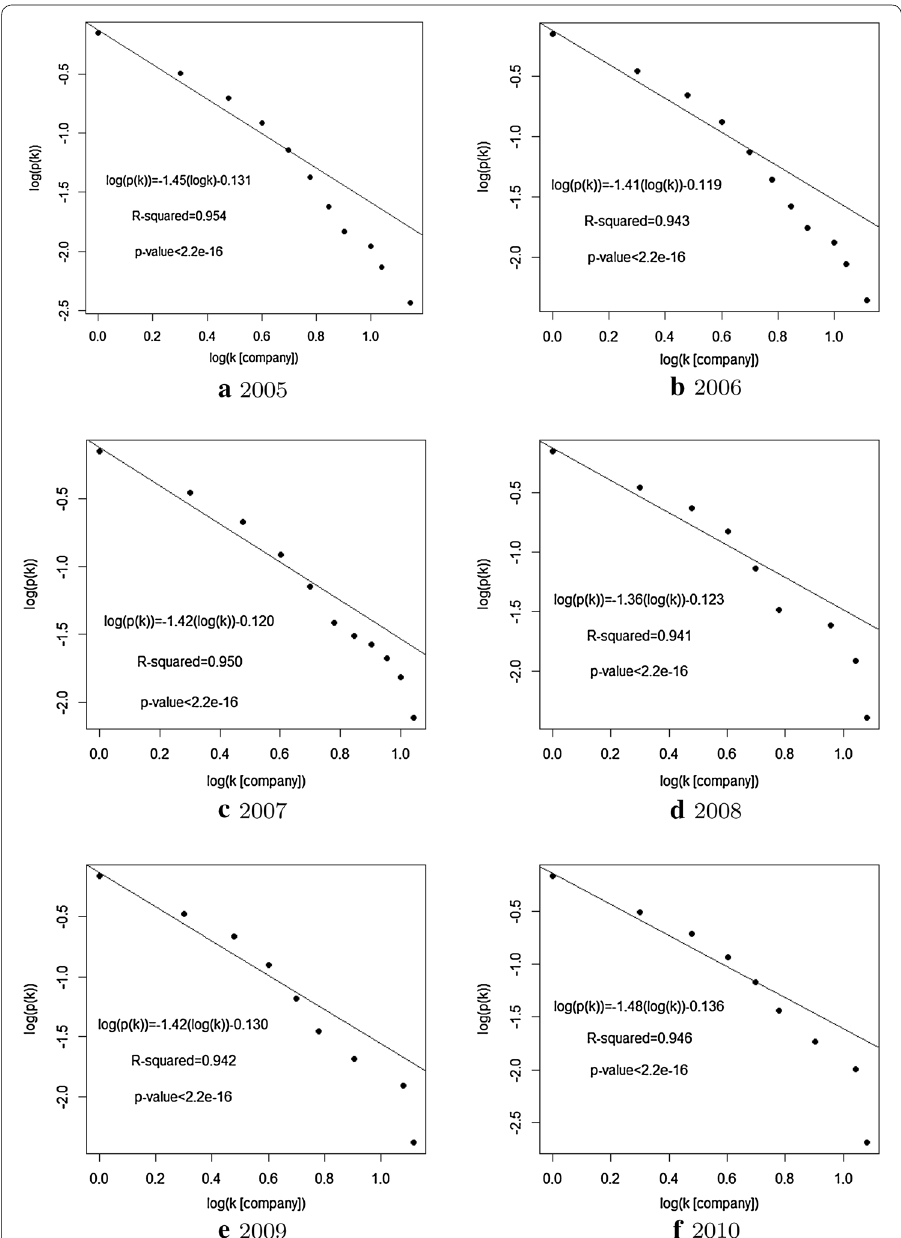
Fig. 5 Degree distributions converted as CCDF from B2B